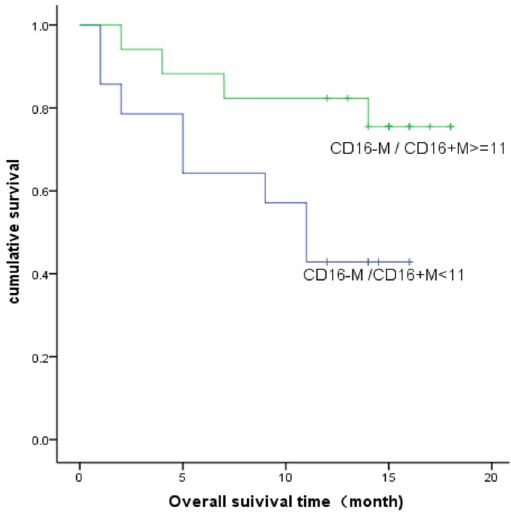
Figure 1. Kaplan-Meier survival curves for overall survival. The 1-year overall survival rate was 0.492 and 0.755 for CD16 − monocyte/CD16 + monocyte ratio of < 11 and ≥ 11 respectively.